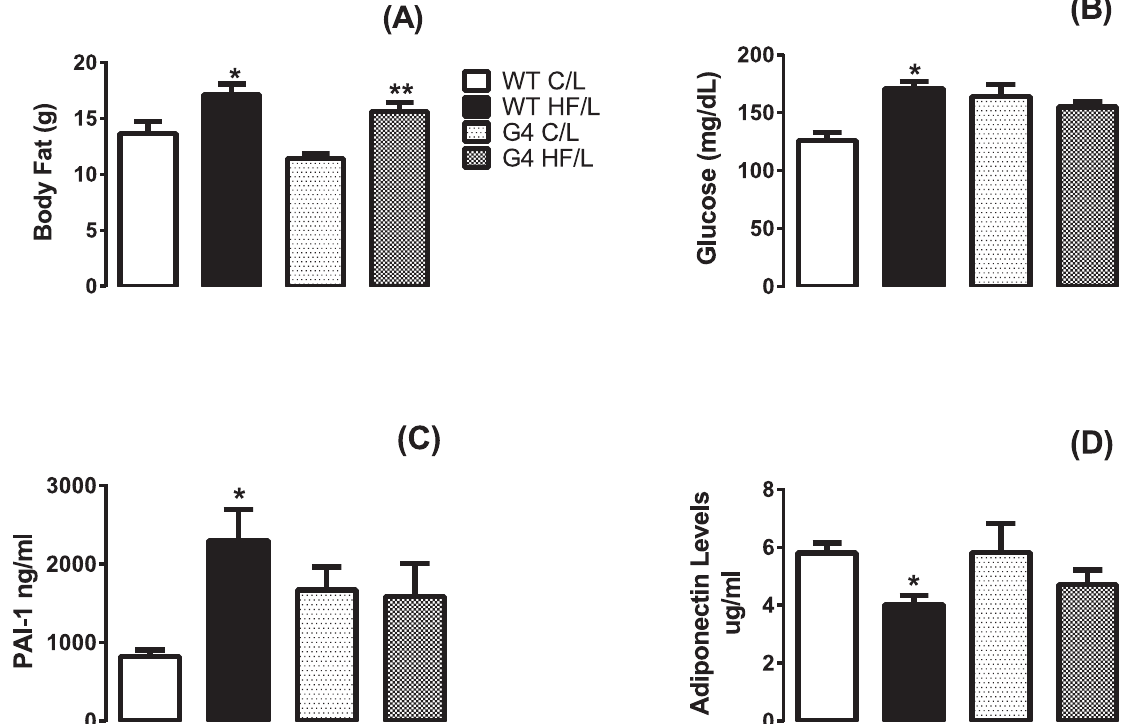
Figure 2. Increased body fat, glucose and PAI-1 and decreased adiponectin levels in 6 wk old WT offspring exposed to HF IU/L. Body fat was determined by MRI (A). Data represent mean 6 SEM, n=5 per group, *p , 0.05 vs. C IU/L, **p=0.027. Fed state blood was collected via retro- orbital sinus between 11PM and 1AM. Plasma glucose (B), PAI-1 (C), and adiponectin (D) levels were determined as described in the Methods section. Data represent mean 6 SEM, n=9–14 per group, *p , 0.05 vs. WT C IU/L.